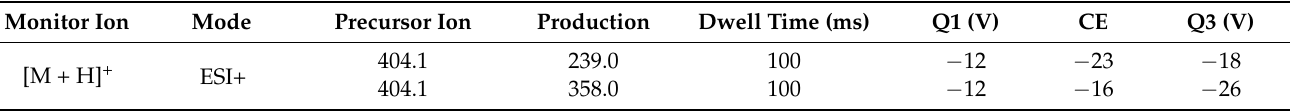
Table A1. MS/MS parameters for OTA determination.